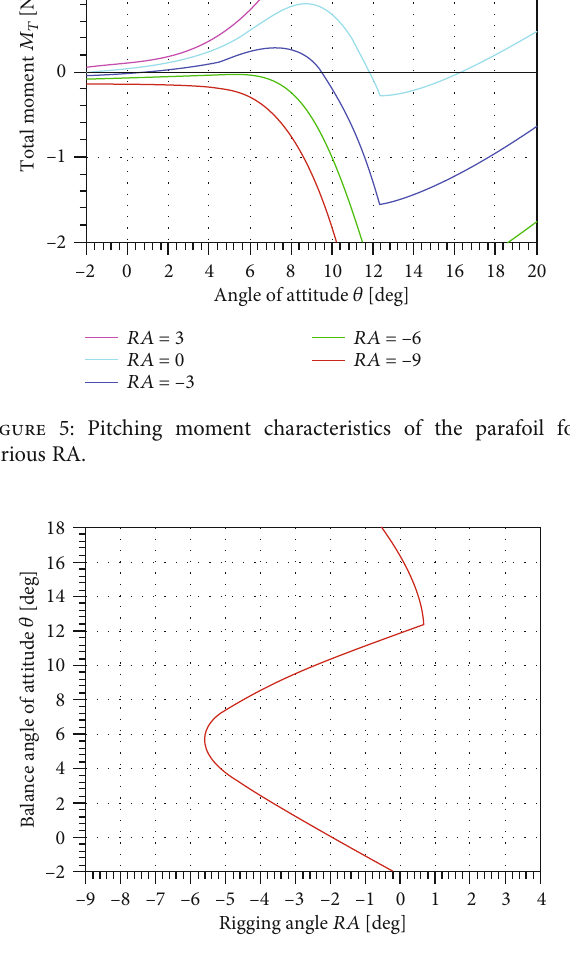
Figure 6: The relation between rigging angle and the angle of attitude in the balanced points.